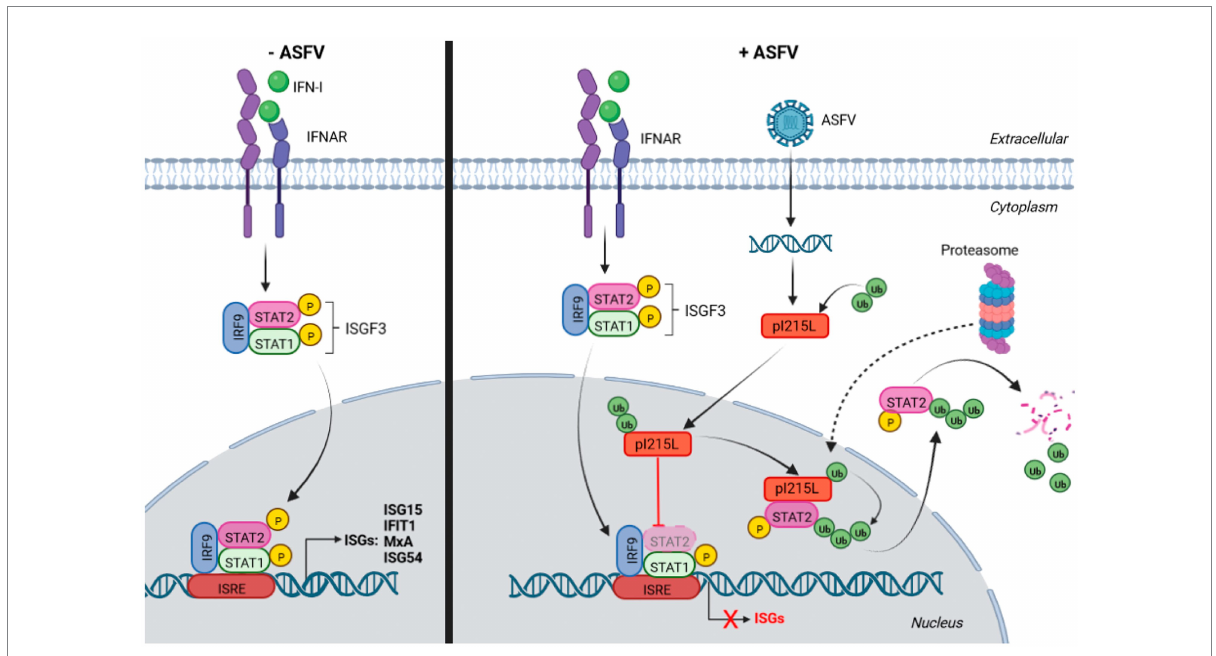
FIGURE 7 Schematic representation of the model of action of pI215L inhibiting the JAK/STAT pathway via STAT2 degradation. On the right side, the activation of the JAK/STAT signaling pathway upon IFN-I stimulus in a non-infected cell is depicted: STAT1 and STAT2 are phosphorylated, together with IRF9 conform the ISGF3 complex, which translocates to the nucleus to act as a transcription factor to induce ISGs transcription. The right side shows the activation of the JAK/STAT pathway in an ASFV-infected cell, where the viral protein I215L interacts with STAT2 in the nucleus, promoting its ubiquitination and degradation, thus preventing ISGF3 complex formation and therefore the transcription of the genes involved in the response to IFN-I. STAT2 degradation by the proteasome has been depicted in the cytoplasm, although the hypothesis that the proteasomal machinery translocates into the nucleus to carry out the degradation of ubiquitinated STAT2 (dashed arrow), cannot be excluded. Biorender program was used for the realization of this